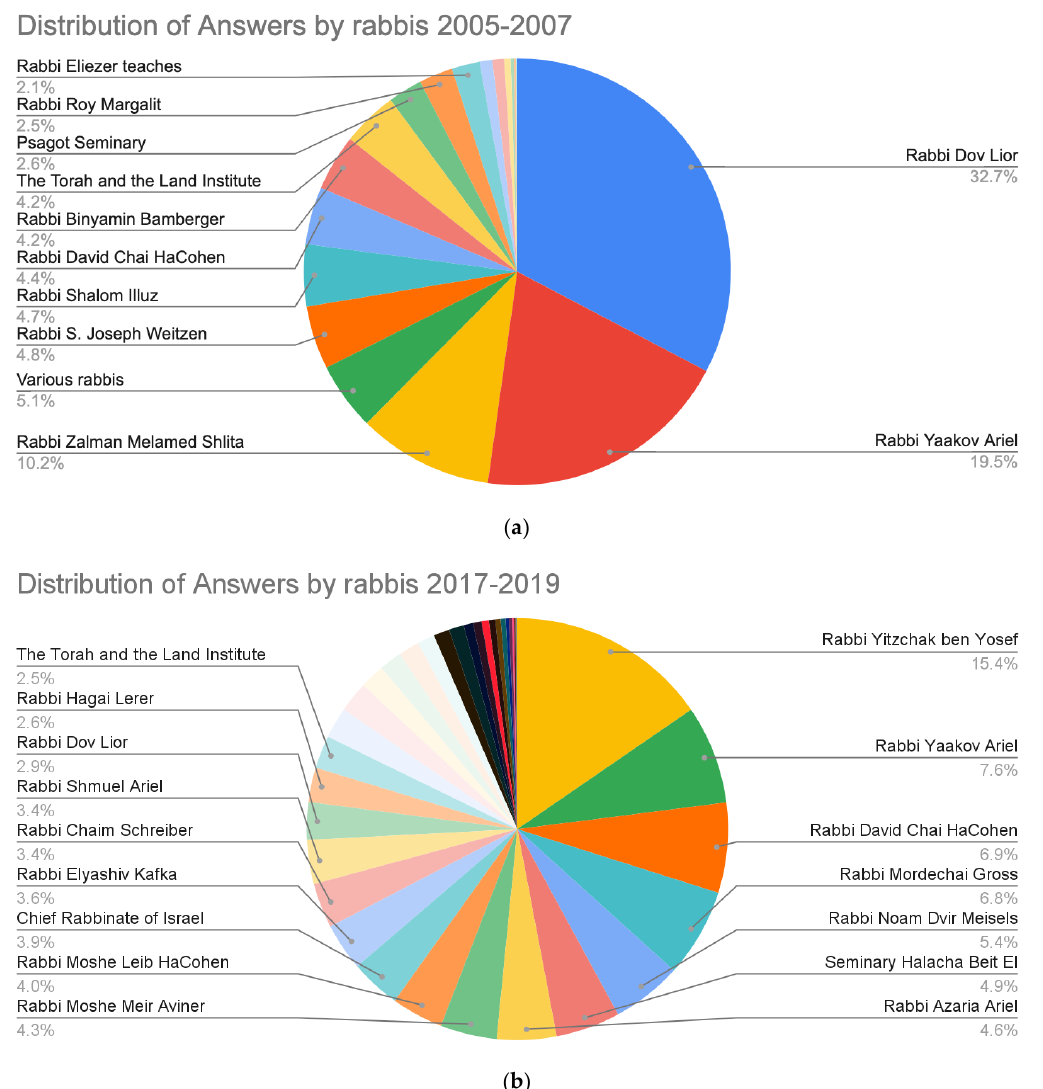
Figure 5. ( a ): Distribution of responses by rabbis between 2005 – 2007. Most were given by three institutionally known rabbis. ( b ): Distribution of responses by rabbis between 2017 – 2019. Responses were provided by a variety of rabbis.